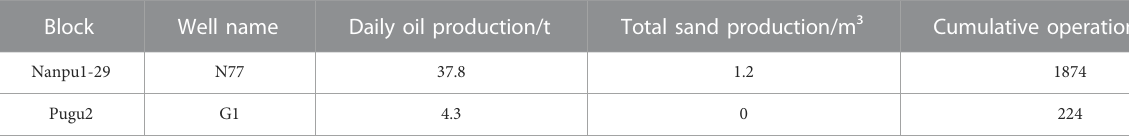
TABLE 1 Condition of coring well.